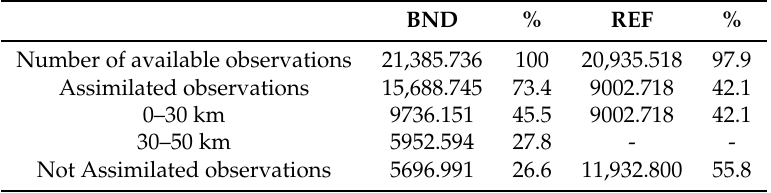
Table 4. Number of available observations and those assimilated in each